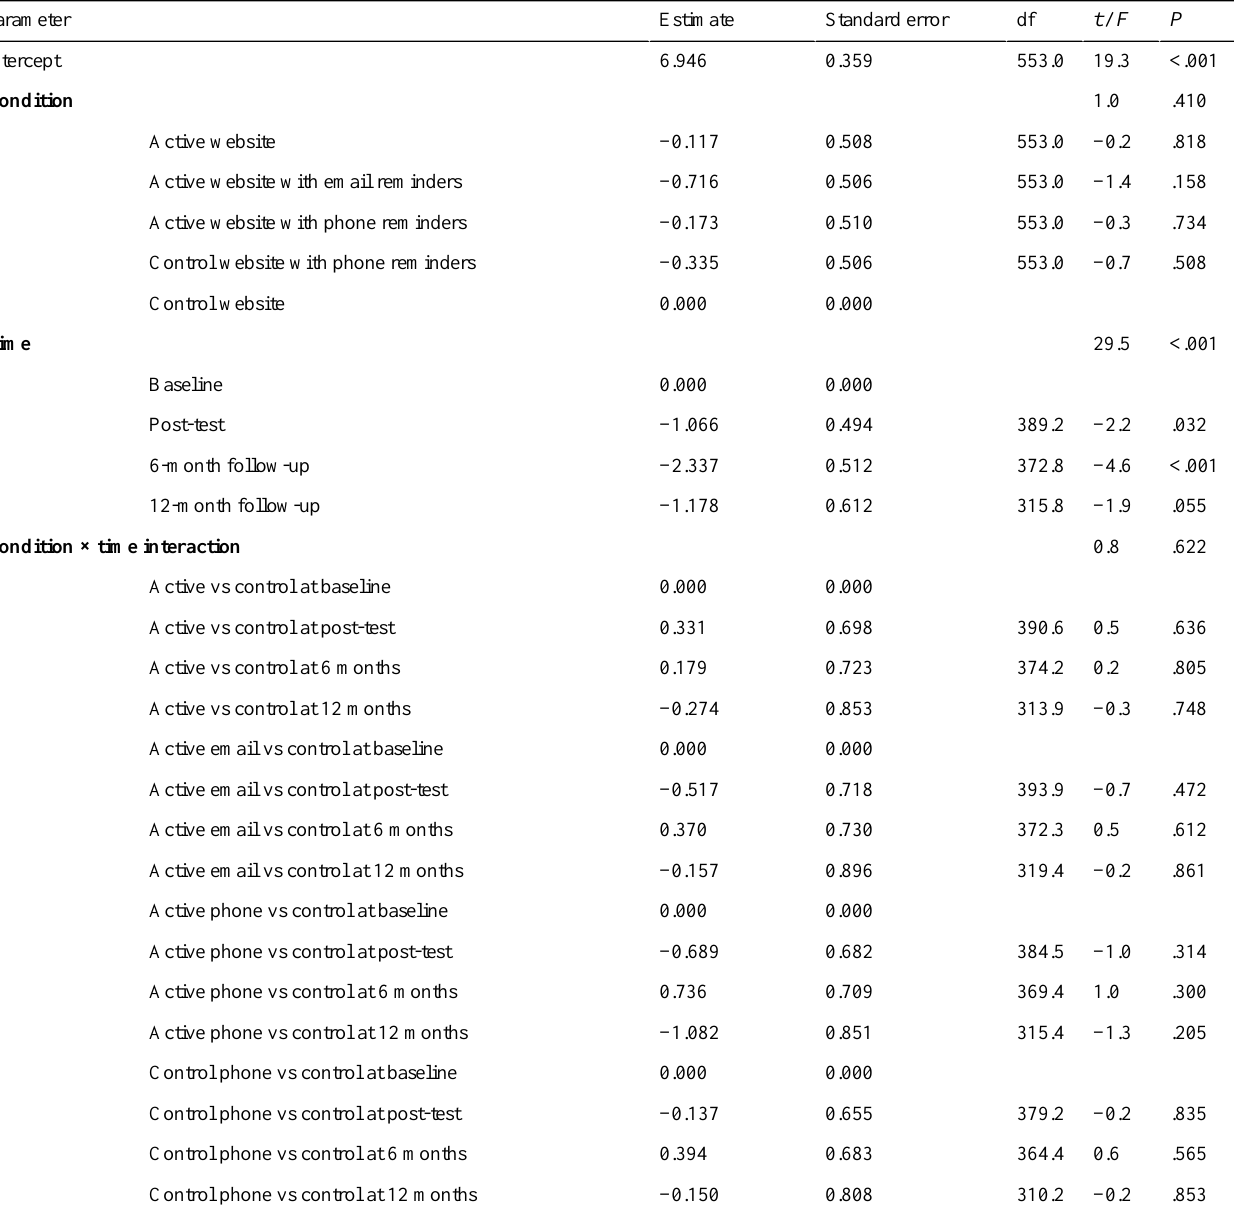
Table 2. Repeated measures mixed model of GAD-7 scores at post-test, 6, and 12 months.